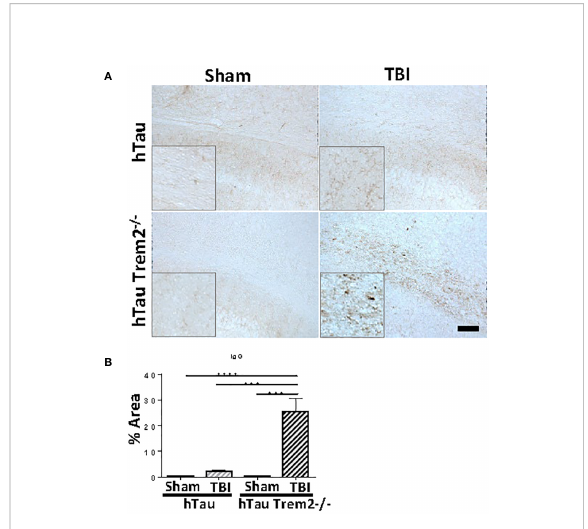
FIGURE 7 Signi fi cant increase of blood-brain barrier leakage in the white matter near the site of tissue damage in hTau; Trem2 -/- mice, but not in other groups. (A) Representative images of hTau and hTau; Trem2 -/- mice with or without TBI stained with IgG in the chronic phase. (B) Quanti fi cation of IgG staining. All experiments used n = 6 (equal males and females) mice per group unless otherwise noted. At least two independent experiments were performed for each analysis. The scale bar represents 100 m m. Error bars indicate SEM; *** p <0.005, **** p <0.001.